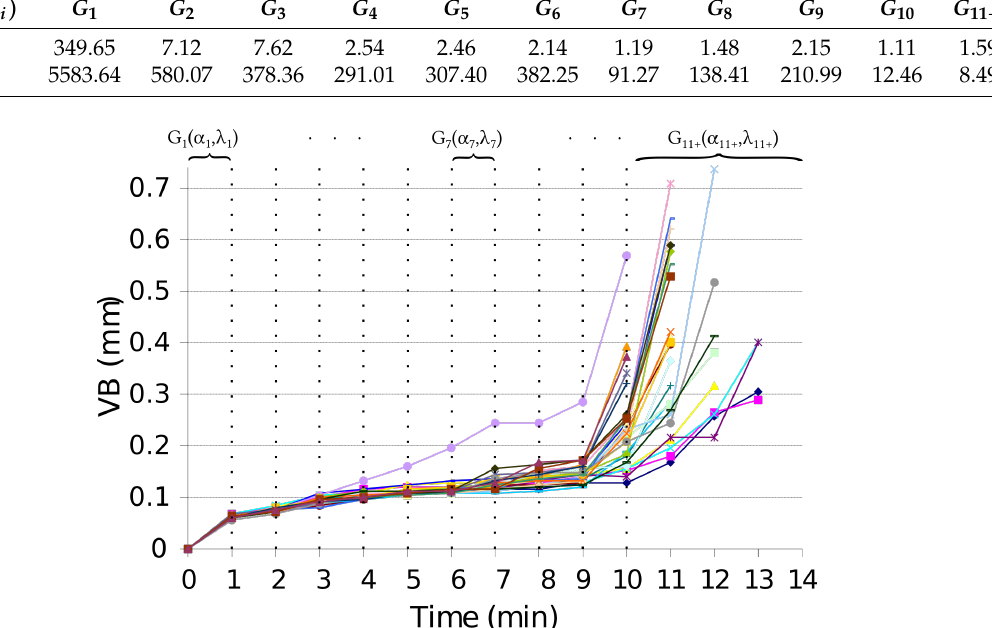
Figure 1. Set of 29 degradation trajectories obtained at 340 m/min during the experimental